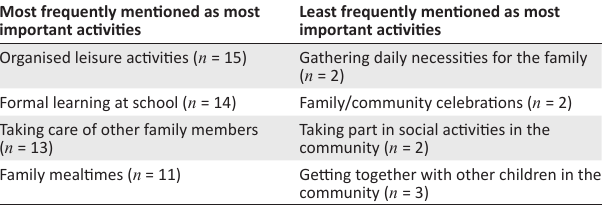
TABLE 1: The activities listed according to the number of children identifying them as most important and those activities least mentioned as important. Most frequently mentioned as most Least frequently mentioned as most important activities important activities Organised leisure activities ( n =